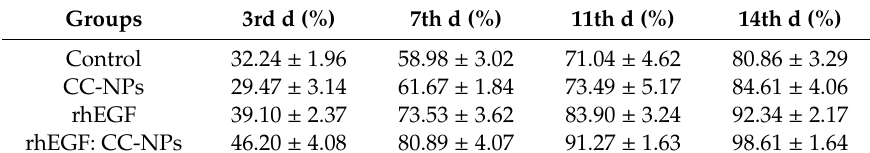
Table 2. Wound closure calculated as a percentage area of the original wound.